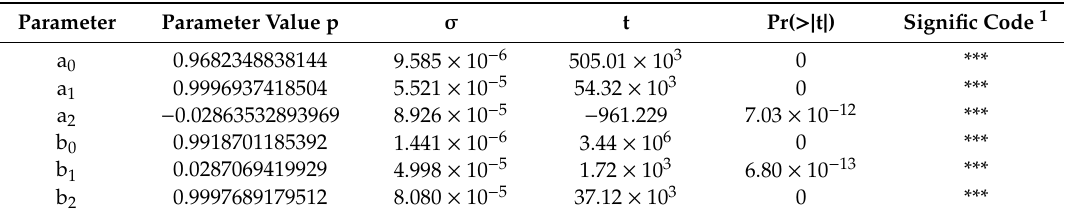
Table A5. A ffi ne transformation parameter value p, standard error σ , t value (t = P significance